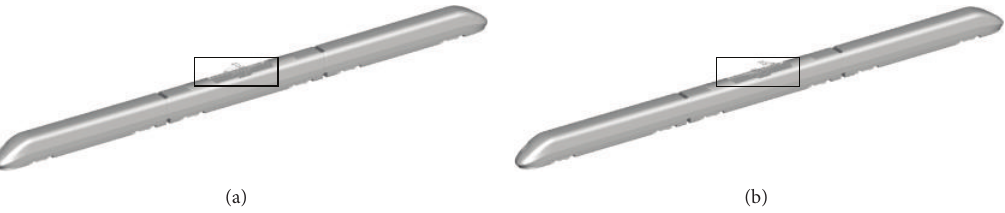
Figure 26: The geometric models of the lifting of different pantographs: (a) Sg1 and (b) Sg2.